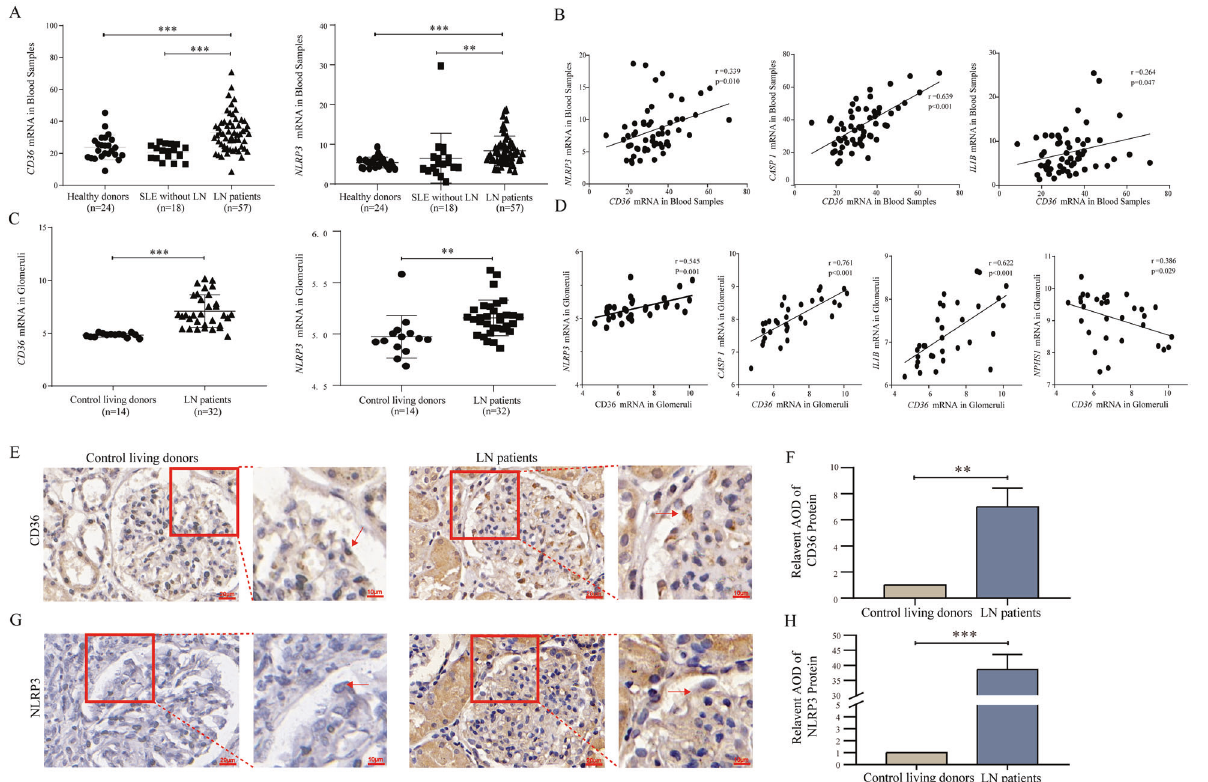
Fig. 1 The expression of CD36 was upregulated and positively correlated with NLRP3 in fl ammasome activation in LN patients. A Scatter plot of CD36 and NLRP3 mRNA expression in whole blood samples from healthy donors ( n = 24), SLE without LN ( n = 18), and LN patients ( n = 57). B Pearson correlation analysis between CD36 and NLRP3 , CASP1 , IL1B mRNA expression in whole blood samples. C Scatter plot of CD36 and NLRP3 mRNA expression in renal glomeruli from Control living donors ( n = 14) and LN patients ( n = 32), relevant data are from GEO database (GSE35291). D Pearson correlation analysis between CD36 and NLRP3 , CASP1 , IL1B , NPHS1 mRNA expression in renal glomeruli, relevant data are from GEO database (GSE35291). E – H Immunohistochemical staining showed the localization and relative quanti fi cation of CD36, NLRP3 protein in renal biopsy specimens of human (scale bar 20 μ m and 10 μ m). The relative expression of protein was indirectly re fl ected by AOD value. The red arrow denoted the most prominent podocyte (original magni fi cation: ×400). Data are expressed as the mean ± SD. ** p < 0.01. *** p <